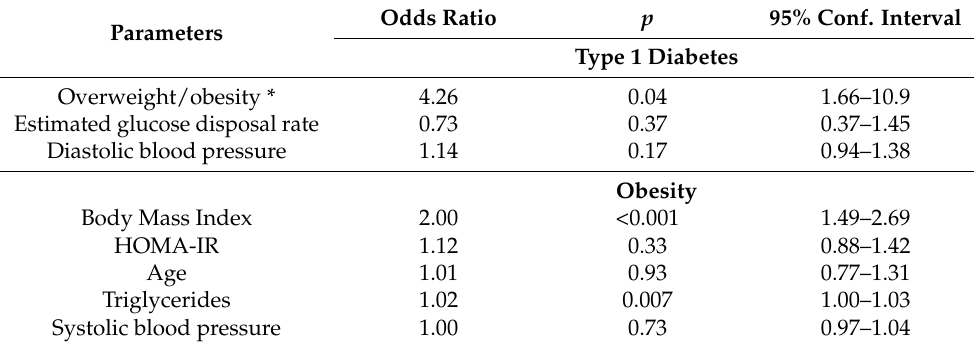
Table 3. Logistic analysis of the main potential confounding factors for AN is